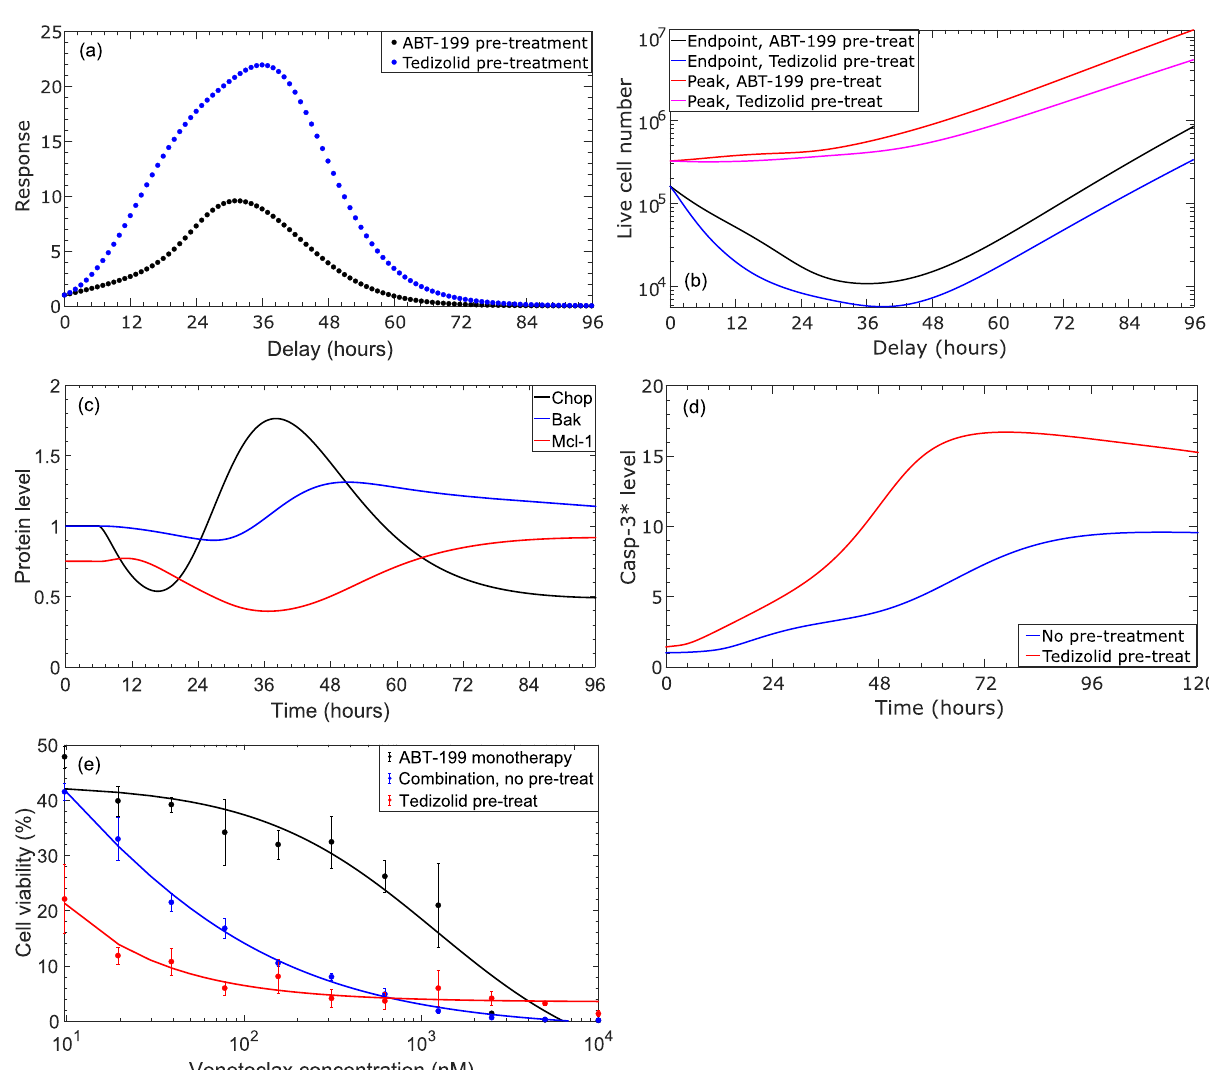
Fig 7. Results of pre-treatment before the administration of 400 nM venetoclax and 5,000 nM tedizolid combination therapy. (a) Simulated response values, calculated using Eq (3), for 400 nM venetoclax administered prior to combination therapy and for 5,000 nM tedizolid administered prior to combination therapy, with the indicated pre-treatment windows. Combination therapy was simulated for 5 days following pre-treatment. (b) Simulated peak and end-point live cell counts during the combination therapy with different pre-treatment windows. In (a) and (b), a pre-treatment window of “0” corresponds to combination therapy without pre-treatment. (c) Simulated expression of Chop, free (inactive) Bak, and free Mcl-1 protein levels after the administration of 5,000 nM tedizolid monotherapy. Each protein was normalized to its total expression in the untreated system. (d) Active Caspase-3 levels, normalized to the level in the untreated system, observed in simulations of combination therapy without pre-treatment and with tedizolid administered 36 hours prior to combination therapy. Time is measured relative to the administration of venetoclax. (e) Experimentally- measured cellular viability for MOLM-13 R2 cells treated with venetoclax monotherapy, combination venetoclax/tedizolid therapy without pre- treatment, or combination therapy with tedizolid pre-treatment administered 48 hours prior, at the indicated venetoclax concentrations. Cellular viability was measured 72 hours after the administration of venetoclax and has been normalized to the cellular viability in the untreated cells. Data points show average and standard deviation of experimental measurements, and solid lines correspond to sigmoidal fits to the data (see text for further